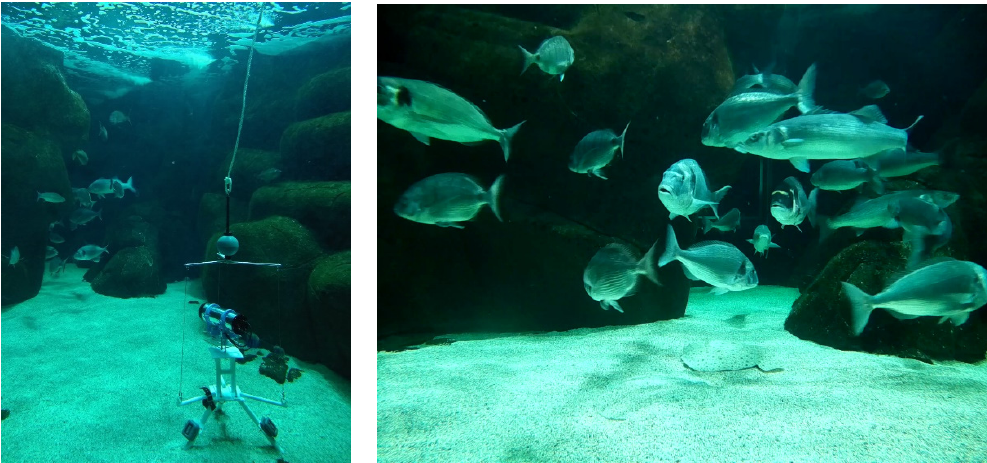
Figure 12. Photo of the KOSMOS 3.0 prototype in the aquarium ( left ). Screenshot of a video recorded in the aquarium in October 2021 ( right ).